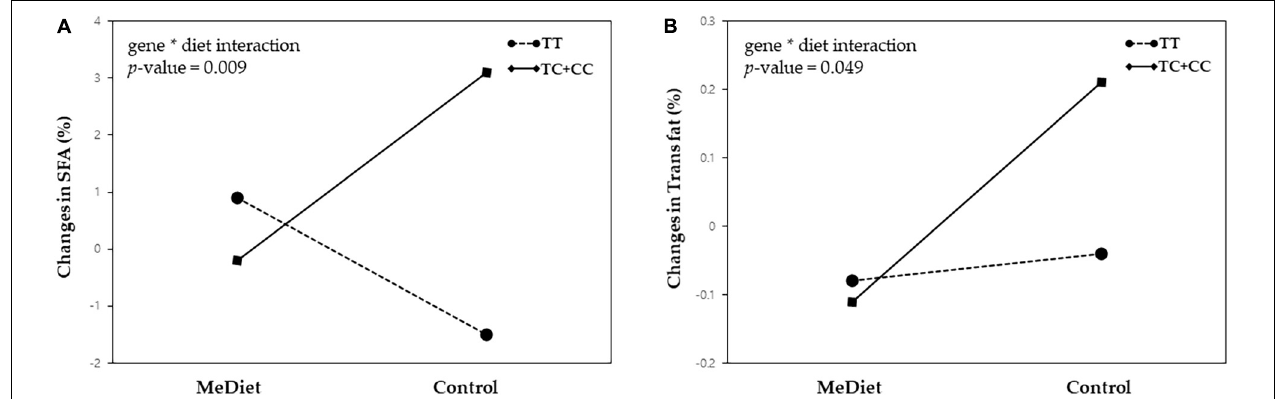
FIGURE 2 | Gene-diet interactions between the MC4R rs476828 variant and dietary intervention for changes in (A) saturated fatty acid (SFA) intake and (B) trans fat intake.